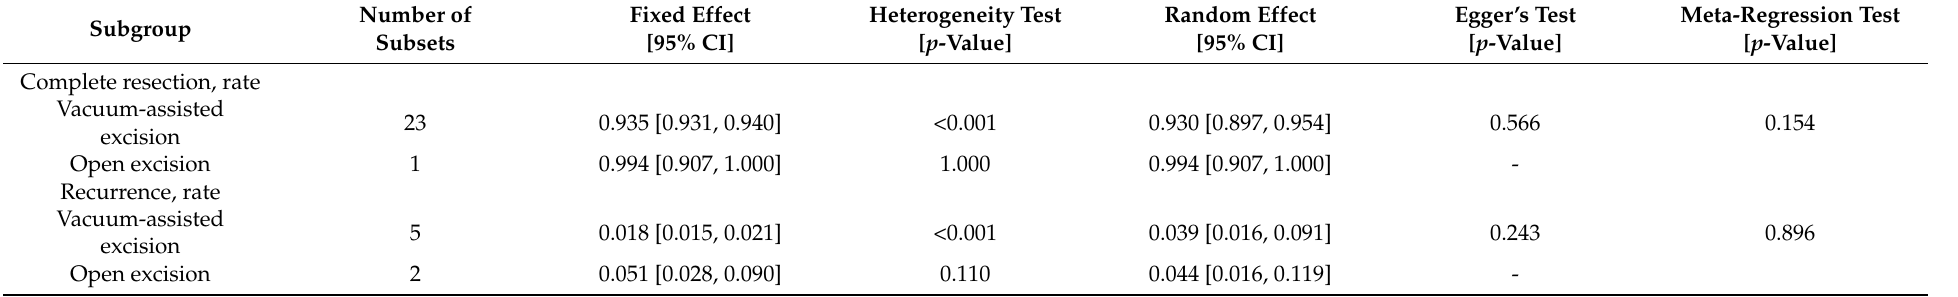
Table 3. The estimated rates of complete resection and recurrence through vacuum-assisted and open